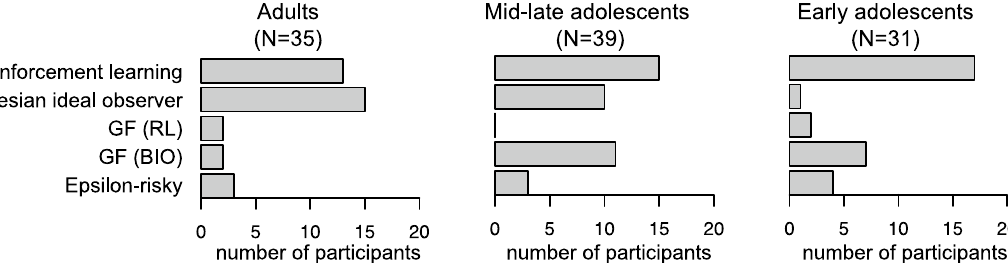
Figure 5. Inferred strategy use according to our mixture-model analysis. The plots show the number of participants per age group assigned to each of the 5 models included in the mixture model. GF = gambler’s fallacy, RL = reinforcement learning, BIO = Bayesian ideal observer. This figure was created using RStudio 1.1.463, https:// www. rstud io. of a 10-cent outcome (convex utility function). This overvaluation of the higher outcomes promotes risk taking, which in our task should impair performance in the risk-disadvantageous blocks but improve performance in the risk-advantageous blocks. However, an advantage for the adolescents over the adults in the risk-advantageous blocks was not apparent in the choice data (Fig. 2), likely due to adolescents’ higher choice stochasticity, as described below. The posterior distribution of the inverse-temperature parameter (cid:31) M β (cid:30) was higher in the adults than in both adolescent groups, but did not differ between the early and mid-late adolescents (9% of the difference distribution lay above 0). The lower inverse temperature in the adolescents than the adults may reflect that that adolescents’ choices were driven less by the options’ expected-value estimates (i.e., they were less prone to choose the option with the highest expected-value estimate), reflecting more stochastic choice behavior. Alternatively, the lower inverse temperature in the adolescents may reflect that the value-updating algorithms implemented in our mod- els were less able to capture the adolescents’ choices. Adolescents’ lower inverse temperature can explain why they made fewer risky choices during the initial trials of a block: Even though the risky option’s initial expected value was similarly optimistic in all age groups, adolescents’ choices were less sensitive to expected values, which resulted in a weaker initial choice preference for the risky option. Adolescents’ low inverse temperature may also explain why their overvaluation of the higher win outcomes (convex utility function)—which should increase the expected value of the risky option—was not translated in a substantial increase in risky choices. In sum, our modeling results identified two mechanisms underlying the impaired adaptation of risky choice behavior over time in adolescents as compared to adults: (i) adolescents used a simpler, suboptimal, learning process involving a constant learning rate; and (ii) adolescents showed a higher degree of choice stochasticity (lower inverse temperature). In addition, the results suggest that the adolescents, but not the adults, overvalued the highest outcomes. The impaired performance of the early compared to the mid-late adolescents may be due to the elevated learning rate (causing excessive expectation updating) and numerically lower inverse temperature in the early adolescents. Results of latent-mixture model analysis including all participants. We performed an additional (not preregistered hence exploratory) latent mixture-model analysis to infer the learning or non-learning strat- egy used by each individual participant, and to examine whether the prevalence of specific strategies differed between our three age groups (Supplemental Text 2). In this analysis, we included all participants. Our mixture model included the two winning learning models from the previous analysis (reinforcement- learning model with nonlinear utility function and Bayesian ideal-observer model with two update rates). In addition, it included two gambler’s fallacy models. These were identical to the two learning models except that they used negative learning/update rates. Thus, the gambler’s fallacy models assume that the value of the risky option decreases following each win outcome and increases following each no-win outcome, reflecting the belief that outcomes that occurred more frequent in the past will be less likely in the future. Finally, we included a fifth model that does not consider the experienced outcomes. This model—the epsilon-risky model—has a fixed prob- ability of choosing the risky option on each trial (determined by parameter ε), hence can account for guessing behavior and general tendencies to seek or avoid risk that are insensitive to outcome feedback. Figure 5 shows the number of participants in each age group assigned to each model (Supplemental Fig. 4 shows the model assignment per participant). The proportion of participants assigned to a learning model (rein- forcement learning or Bayesian ideal-observer) did not differ across the three age groups ( χ 2 (2, n = 105) = 4.0, p = 0.14). For the participants assigned to a learning model, the proportion of participants assigned to the reinforce- ment-learning vs. Bayesian ideal-observer model differed across the three age groups ( χ 2 (2, n = 71) = 11.1, p = 0.004). While the proportion of participants assigned to the Bayesian ideal-observer model was highest in the adults and lowest in the early adolescents, the proportion of participants assigned to the reinforcement-learning model showed the opposite pattern, corroborating the model-comparison results from the previous analysis. Finally, a few participants in each age group were assigned to the epsilon-risky model, suggesting that their tendency to choose the risky option was constant over time and independent of the experienced outcomes.